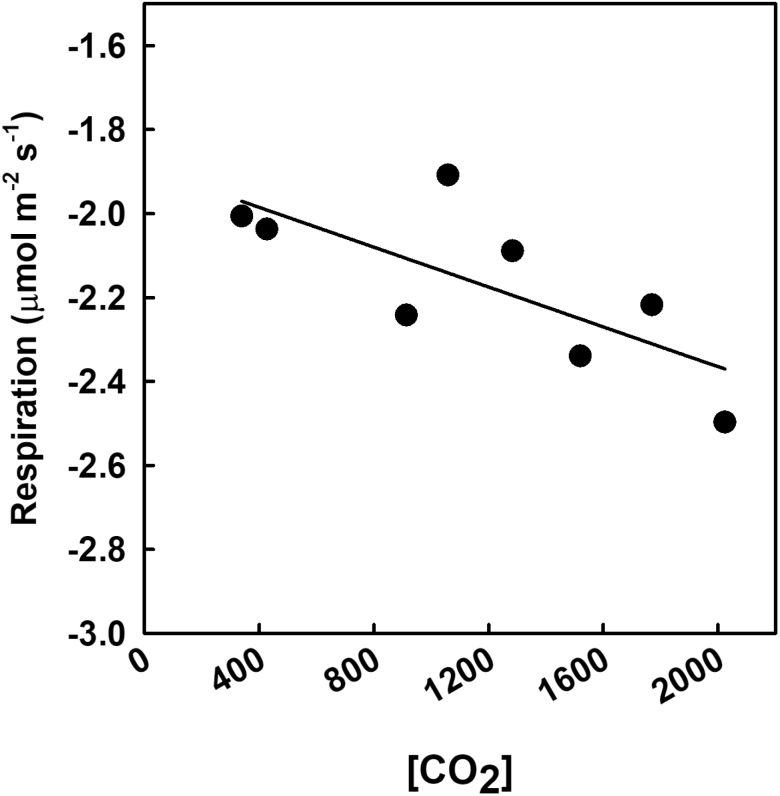
Dark respiration as a function of [CO2] measured at 35 DAE. Each point represents the average from each treatment. A statistically significant relationship (P<0.1) as a function of [CO2] is indicated by a fit plotted through the data. The R2 value is indicated in the figure.